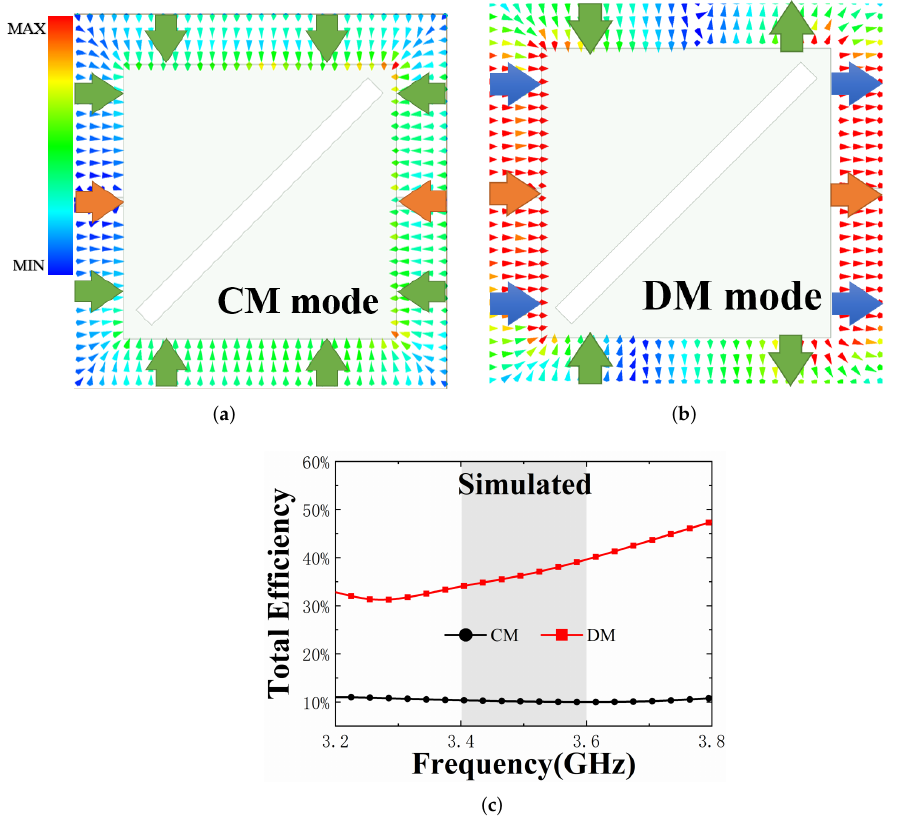
Figure 6. Electric field distribution of the square loop slot at ( a ) CM mode. ( b ) DM mode. ( c ) TE of the two